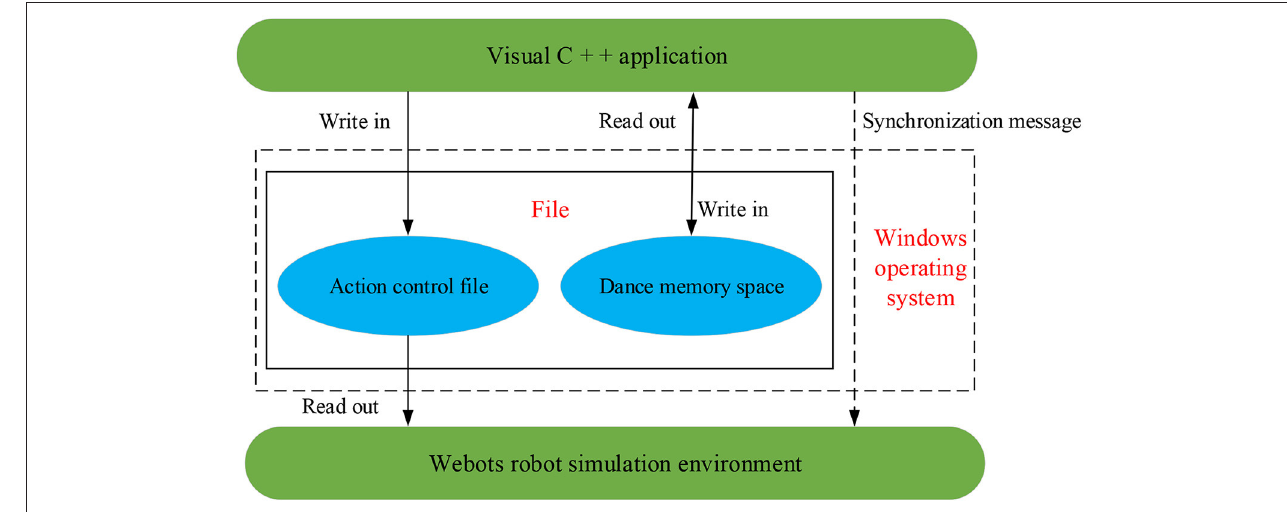
FIGURE 7 | Relationship among Windows, Webots, and Visual C ++ .